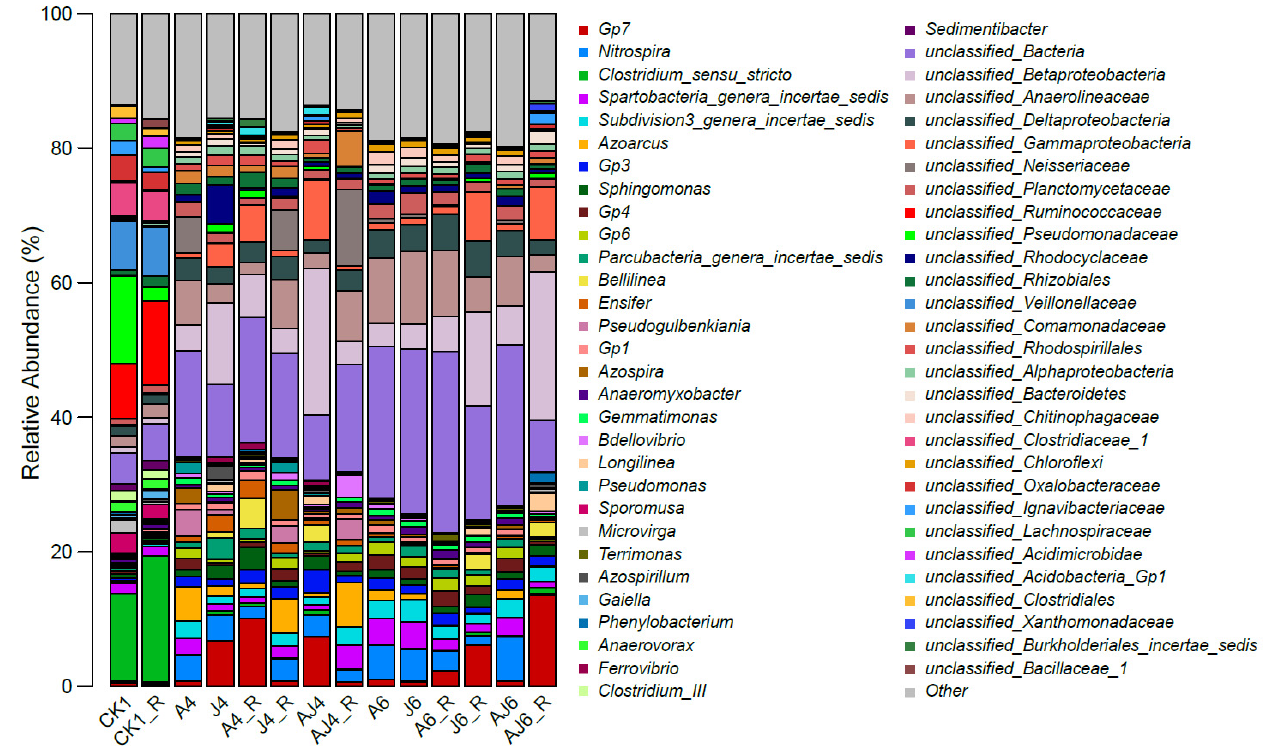
Figure 8. Relative abundance of bacteria at the genus level under different treatment conditions (only genera showing relative abundances greater than 1% during degradation of β -HCH; those at less than 1% and those not detected were classified as Other).